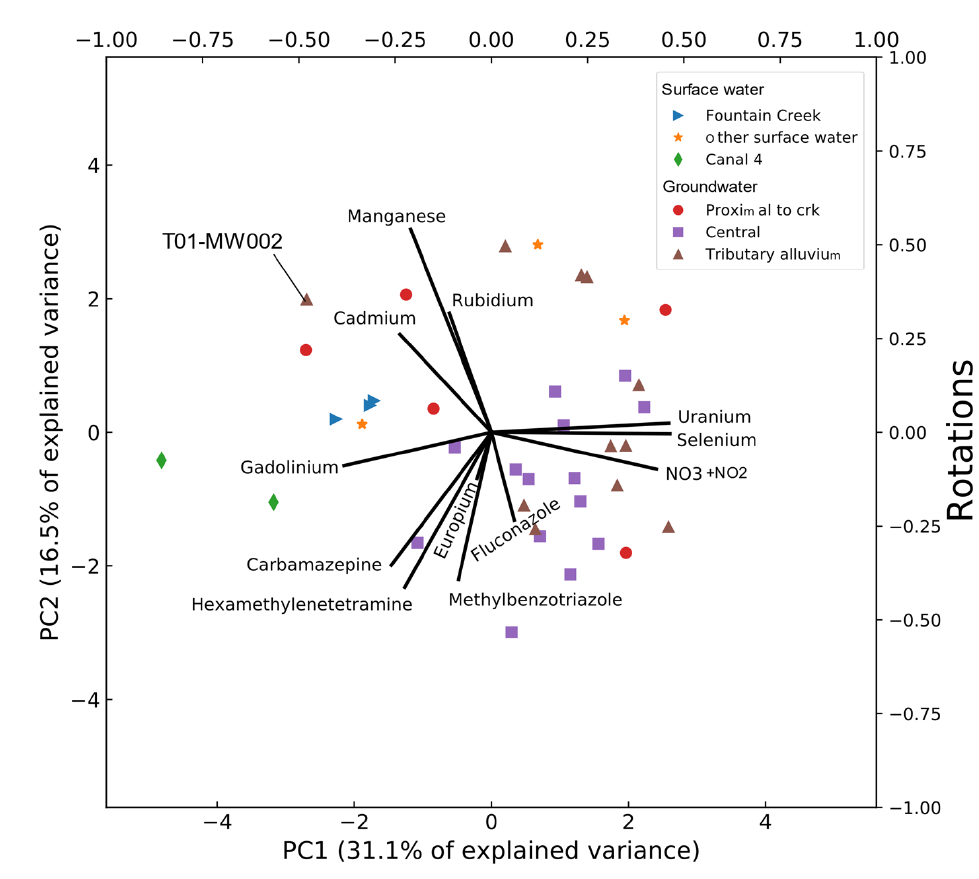
Figure 5. Results of principal component analysis (PCA) for subset of geochemical parameters. Rays are plotted against rotations (top and right axes), and sample results are plotted against principal component loadings (bottom and left axes).